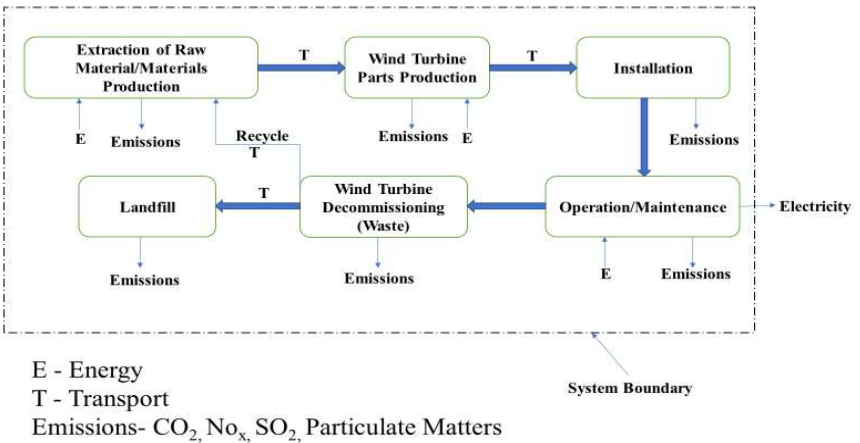
Figure 1. System boundary for wind power.